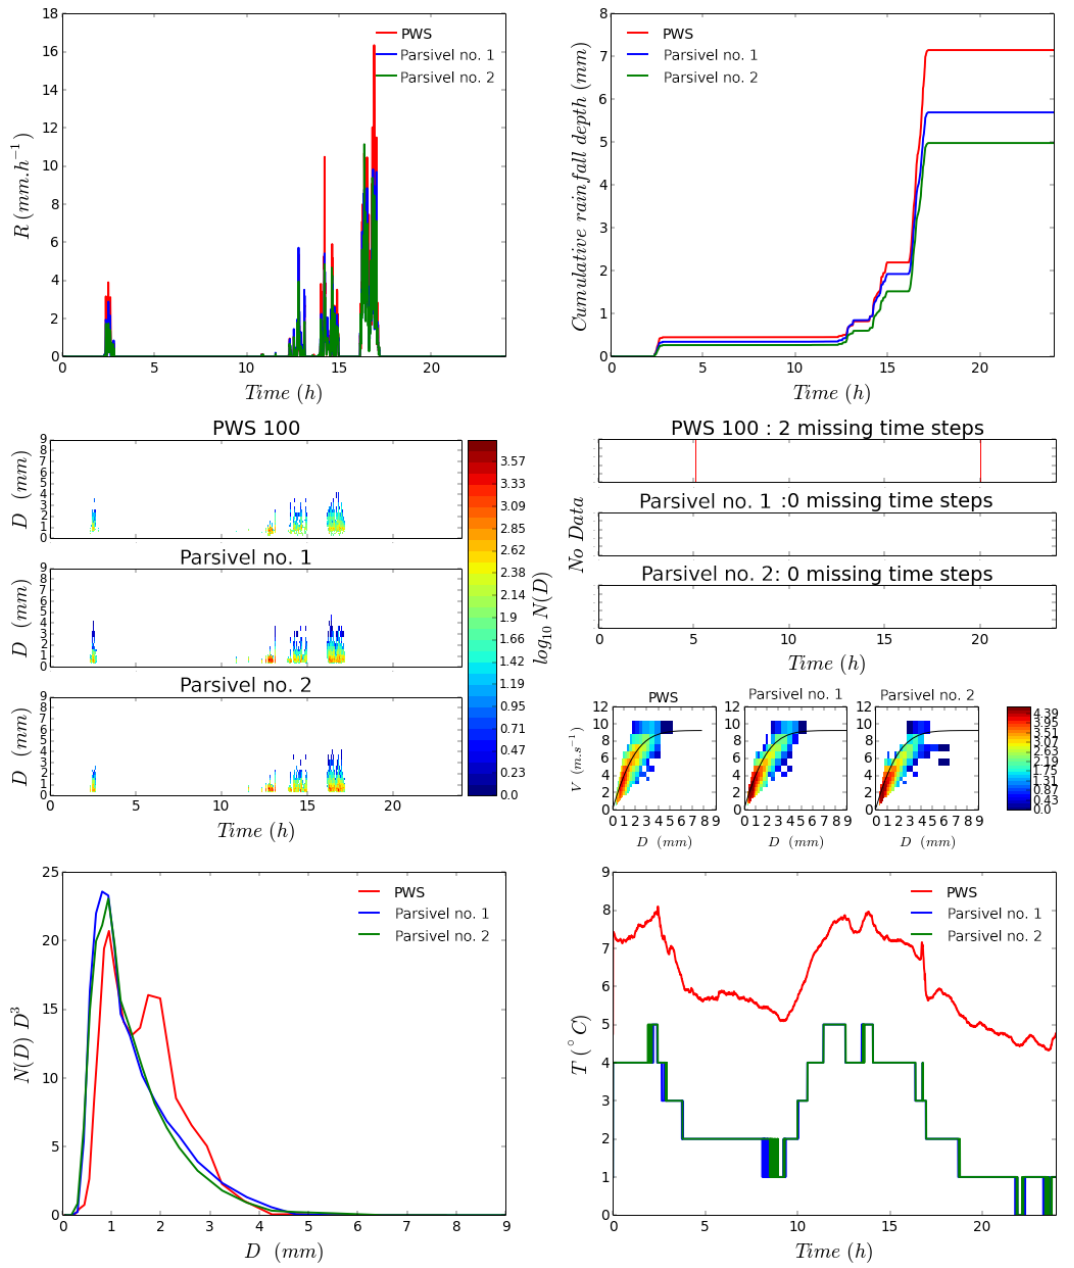
Figure 4. Quicklook of the disdrometer data available on 10 January 2016.